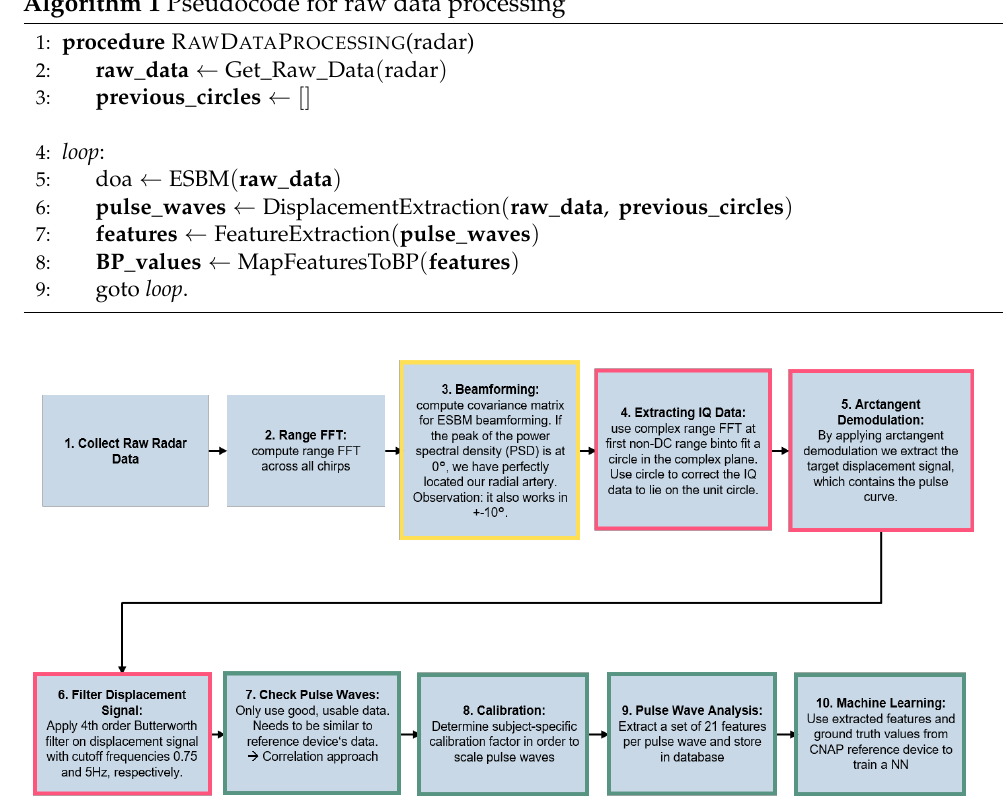
Figure 5. Employed signal processing pipeline. The boxes are colored according to their method Algorithm 1 Pseudocode for raw data processing